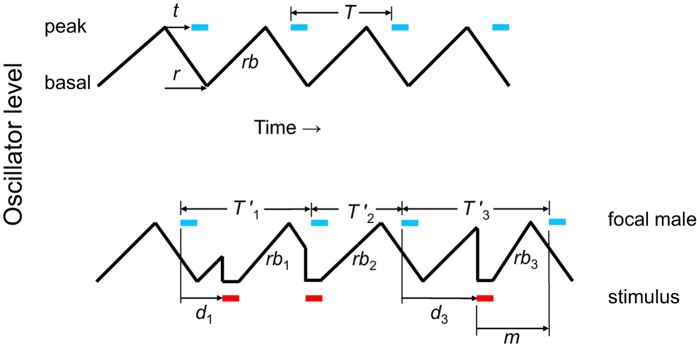
Inhibitory-resetting model for signal interactions between male neighbors in rhythmic acoustic species.Black sawtooth line in upper trace shows the periodic ascent (rb, rebound) and descent of the free-running central rhythm generator. After an effector delay t following ascent to the peak level, a call (thick blue dash) is broadcast; meanwhile the generator descends to its basal level over interval r. Calls are repeated rhythmically with a period T. Lower trace shows the same central rhythm generator as it is repeatedly inhibited and reset by a stimulus (male neighbor or acoustic playback; thick red dash). T′ is the modified call period following a stimulus. The rebound rb from inhibition following a stimulus steepens when the stimulus occurs after a longer post-call delay d; rb is steepest (rb3) when the stimulus occurs just as the rhythm generator has ascended to its peak level (following post-call delay d3), yielding the shortest post-stimulus delay for the focal male’s next call. This minimum post-stimulus call delay is designated m. The model is adapted from ref. 21 and was derived from results in extensive playback experiments with various species, including E. diurnus.